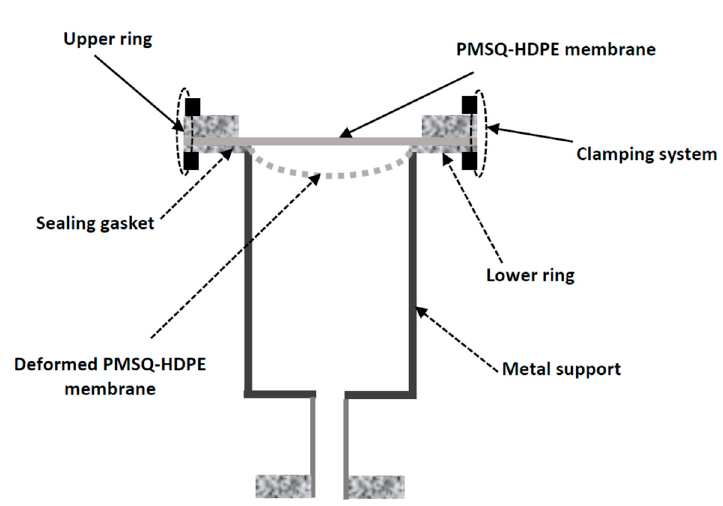
Figure 2. Fixation Figure 2. Fixation module. Figure 2. Fixation module.